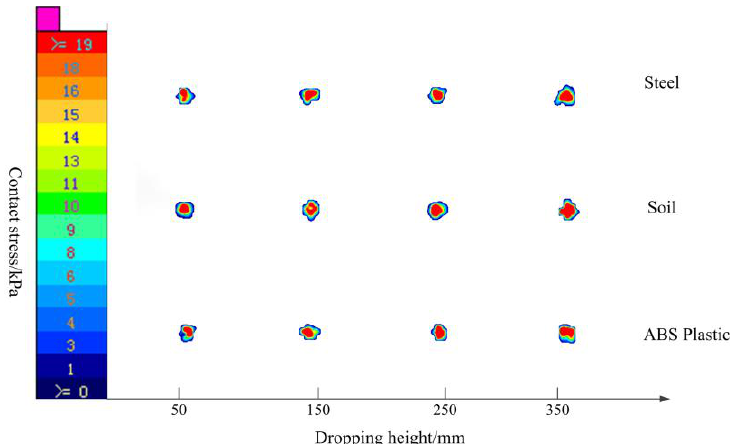
Figure 9. Typical stress distribution of oil sunflower plug seedlings of different contact materials under different drop heights.